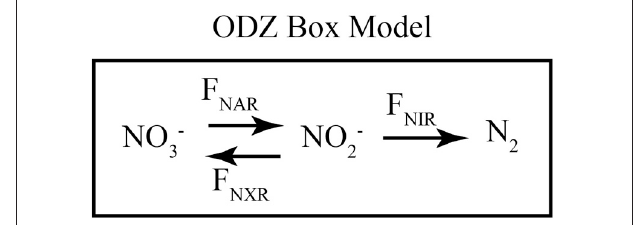
FIGURE 5 | Schematic of ODZ box model. A schematic of the fluxes included in the time-dependent1-box ODZ model. NO − 3 is reduced to NO − 2 through nitrate reduction (F NAR ). NO − 2 can be consumed either through dissimilatory nitrite reduction (F NIR ) or nitrite oxidation (F NXR ). The rates of these processes are assumed to be first order in NO − 3 or NO − 2 , respectively, and isotope effects control the relative reaction of heavy and light isotopes. Table 1 gives the values of the parameters used in the model.